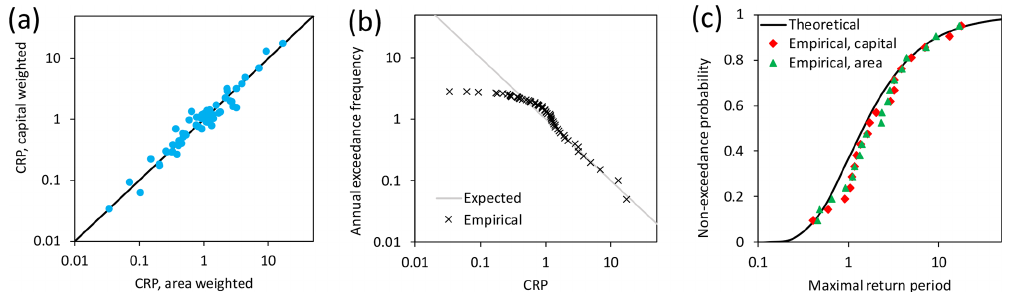
Figure 5. Results of the analysis: (a) comparison of area and capital-weighted CRPs, (b) comparison of theoretical and observed exceedance frequency of capital-weighted CRP, and (c) test of distribution of seasonal maxima of